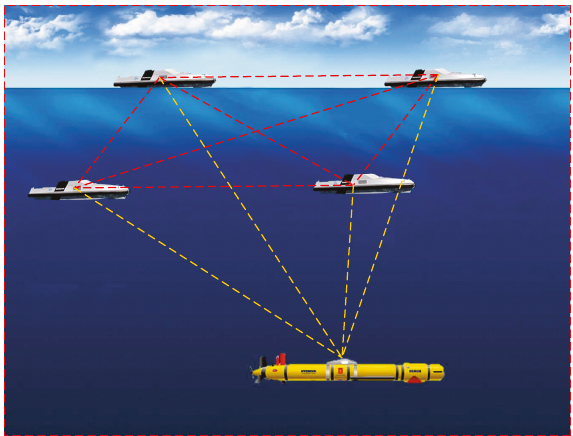
Figure 1: MLBL system consists of four USVs